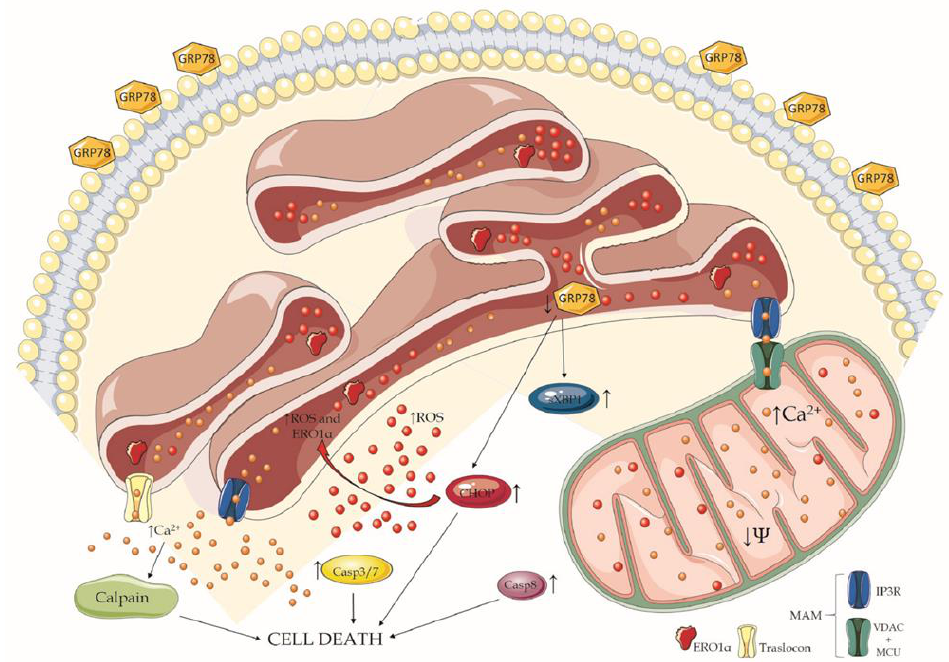
Figure 8. Diagram representing the mechanism of BOLD-100 toxicity on mesothelioma cells. The schematic art pieces utilized were obtained by Servier Medical art (http://smart.servier.com/, ac- cessed on 18 May 2022). Servier Medical Art by Servier is licensed under a Creative Commons Attribution 3.0 Unported